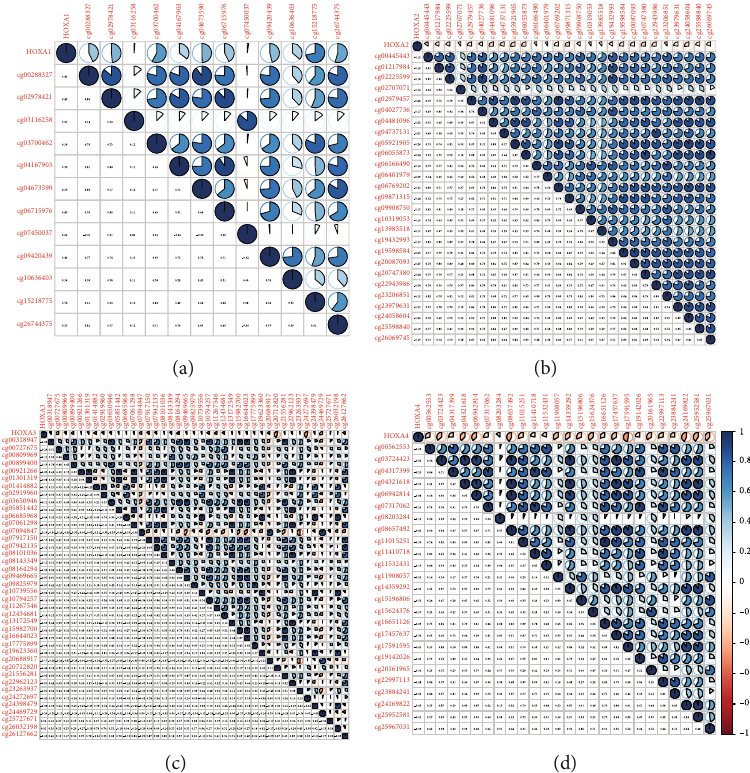
Figure 4: Pearson ’ s correlation between methylation degrees and the expression of (a) HOXA1, (b) HOXA2, (c) HOXA3, and (d) HOXA4.